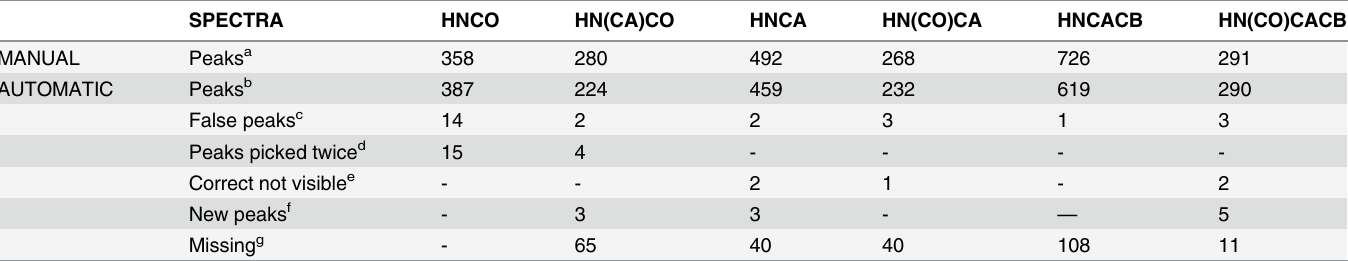
Table 2. Comparison of automated and manual peak picking of the spectra in the TA approach. SPECTRA